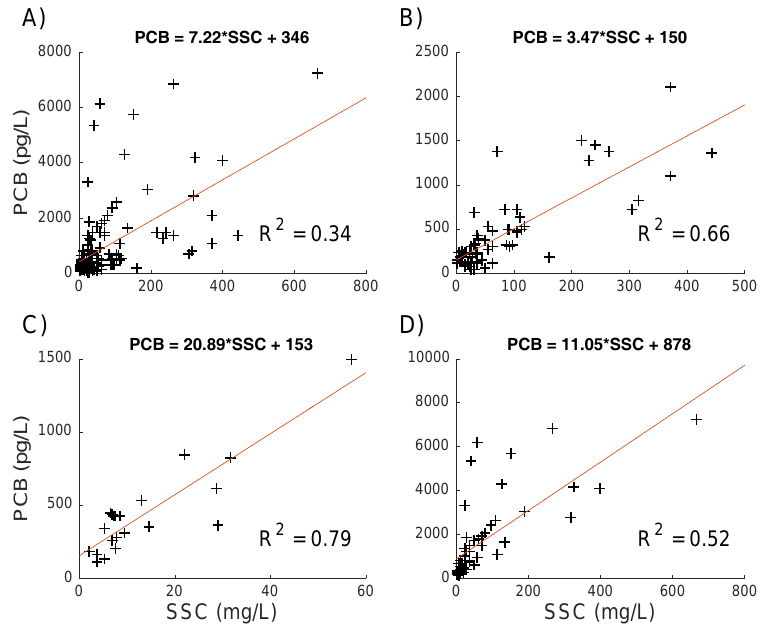
Figure 2. Relationship between in situ PCBs and suspended sediment concentration (SSC) in the the SFB for ( A ) the entire the SFB (data collected February, April, July, August, 1998–2006); ( B ) Northern Bay (data collected February, April, July, August, 1998–2006); ( C ) South ‐ Central Bay (data collected July, August, 2002–2006); ( D ) Southern Bay (data collected February, April, July, August, 1998–2001). All data were collected at stations within the SFB (see Figure 1 for locations). Black cross symbols indicate in situ PCB and SSC samples. The red line is the best ‐ fit linear regression. All relationships are statistically significant at the 99% confidence level and highly significantly different (ANCOVA; p < 0.001). Table 1. Statistical relationships between SFEI ‐ sampled PCBs and SSC. a